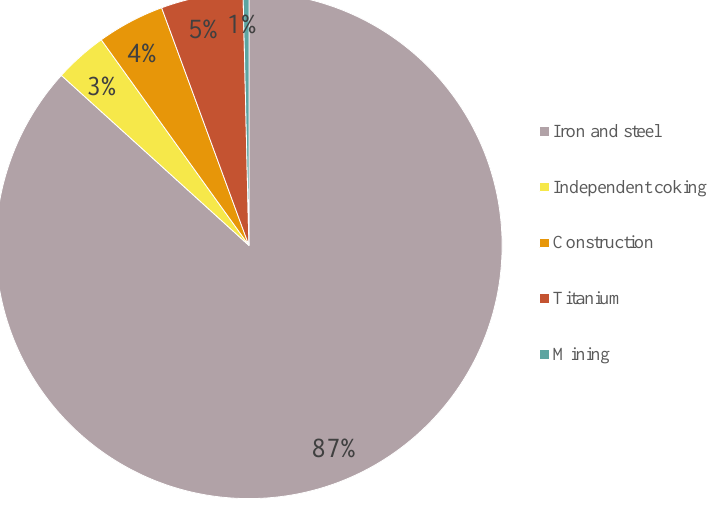
Figure 8. Energy demand share of industries in Panzhihua City .